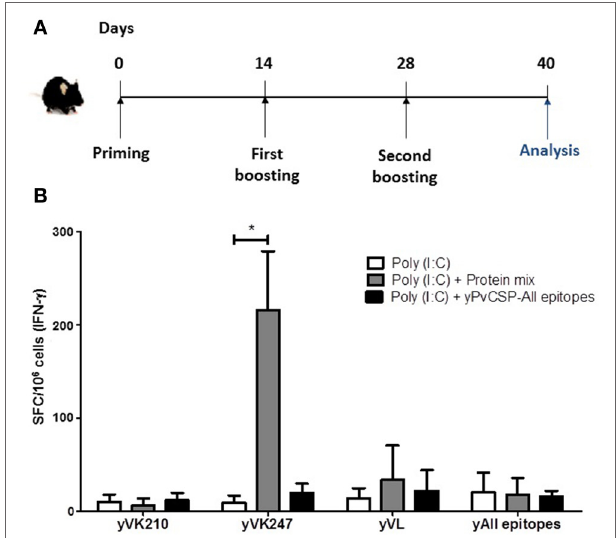
FigUre 6 | Interferon gamma (IFN- γ )-producing cells in mice immunized with recombinant proteins. (a) C57BL/6 mice were immunized following the scheme with yPvCSP-All epitopes (3 μ g/mouse) or a mix of yPvCSP- VK210 + yPvCSP-VK247 + yPvCSP- P. vivax -like (1 μ g/each protein/mouse), in the presence of the adjuvant Poly(I:C). (B) To measure the number of cells secreting IFN- γ , splenocytes collected from immunized C57BL/6 mice on day 40 after priming were used for enzyme-linked immunospot (ELISPOT) assays. The recombinant proteins yPvCSP-VK210 (yVK210), yPvCSP-VK247 (yVK247), yPvCSP- P. vivax -like (yVL), and yPvCS-All epitopes (yAll epitopes) were used as stimuli (10 µg/mL). SFC, spot forming cells. Asterisk denotes statistical differences ( P <